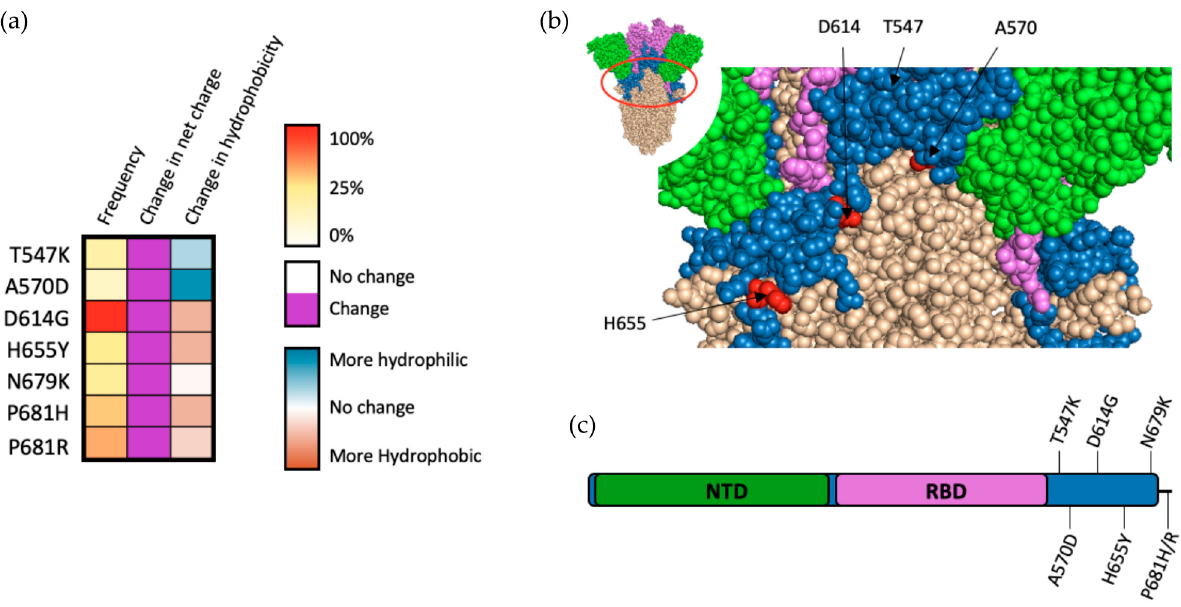
Figure 5. Mutations occurring outside of major SARS-CoV-2 spike subdomains. ( a ) Frequency, charge modifications, and alteration in hydrophobicity for mutations occurring outside of major spike subdomains. ( b ) Structural representation of mutations occurring within this region (P681 is not shown, as it is on the other surface of the current 3D view). ( c ) Schematic representation of mutations occurring outside of major spike subdomains.